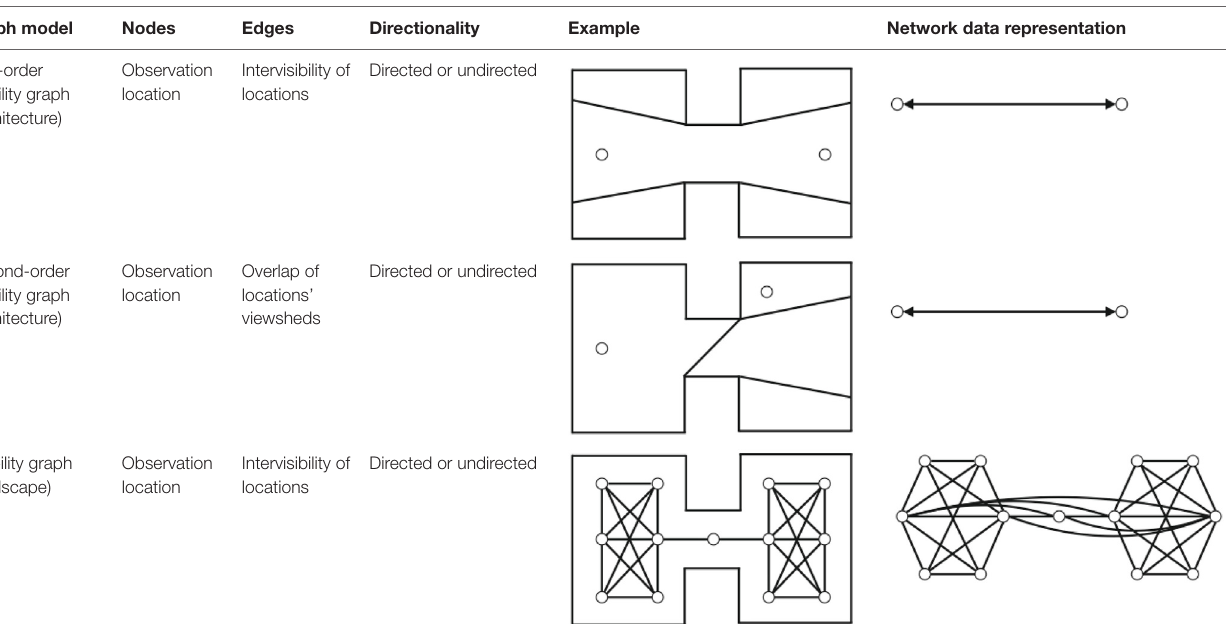
TaBle 1 | Summary of multi-disciplinary overview of network data representation for visual relational